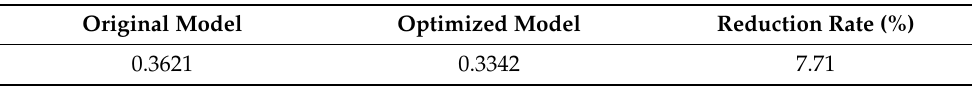
Table 9. Comparison for aerodynamic drag coefficient.